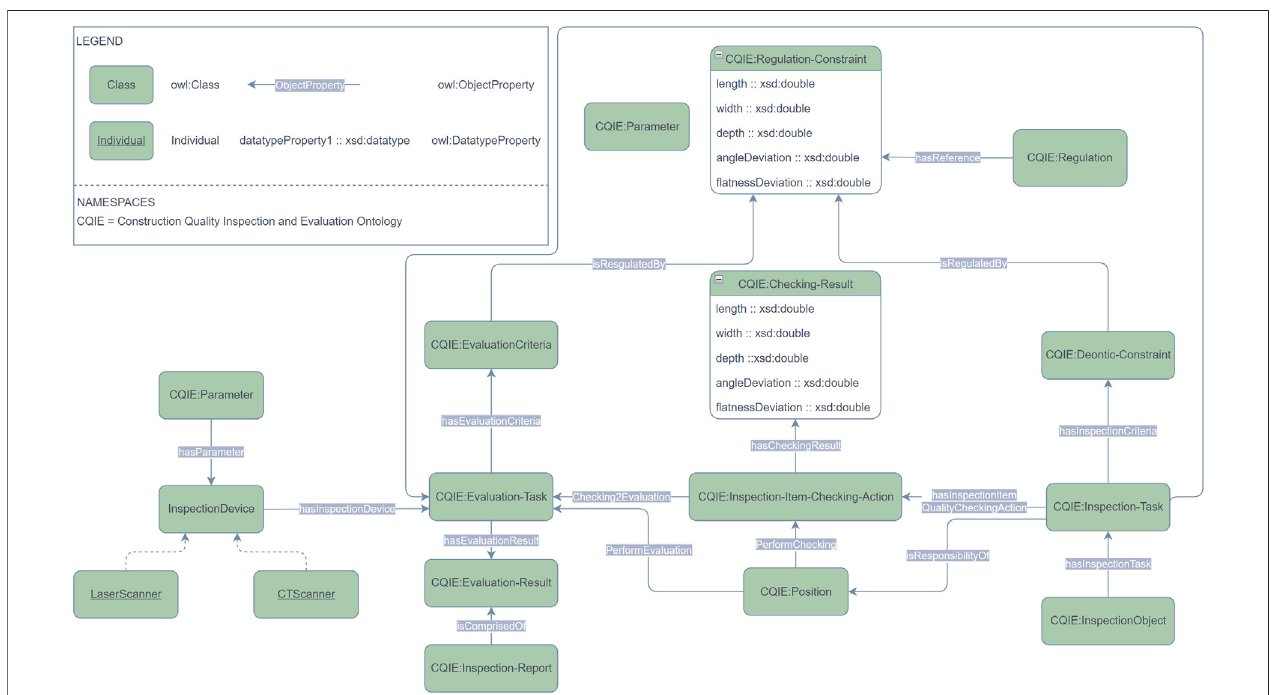
FIGURE 4 | Metamodel for the Ontology of the Quality Control Submodel based on Zhong et al. (2012).